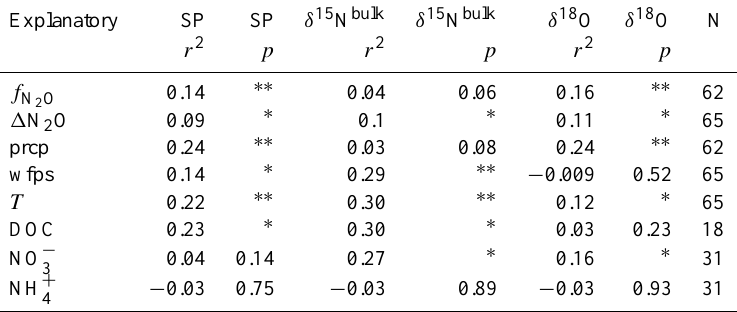
Table 2. Adjusted r 2 and p values for regression analysis of Keeling-plot-derived isotopic compositions in soil-emitted N 2 O versus auxiliary variables N 2 O flux ( f N ), difference of maximum and minimum concentration over a noon-to-noon period ( (cid:49) N 2 O), precipitation (prcp), 2 O soil moisture (wfps), and nutrient concentrations (NO − , NH + and DOC). 3 4